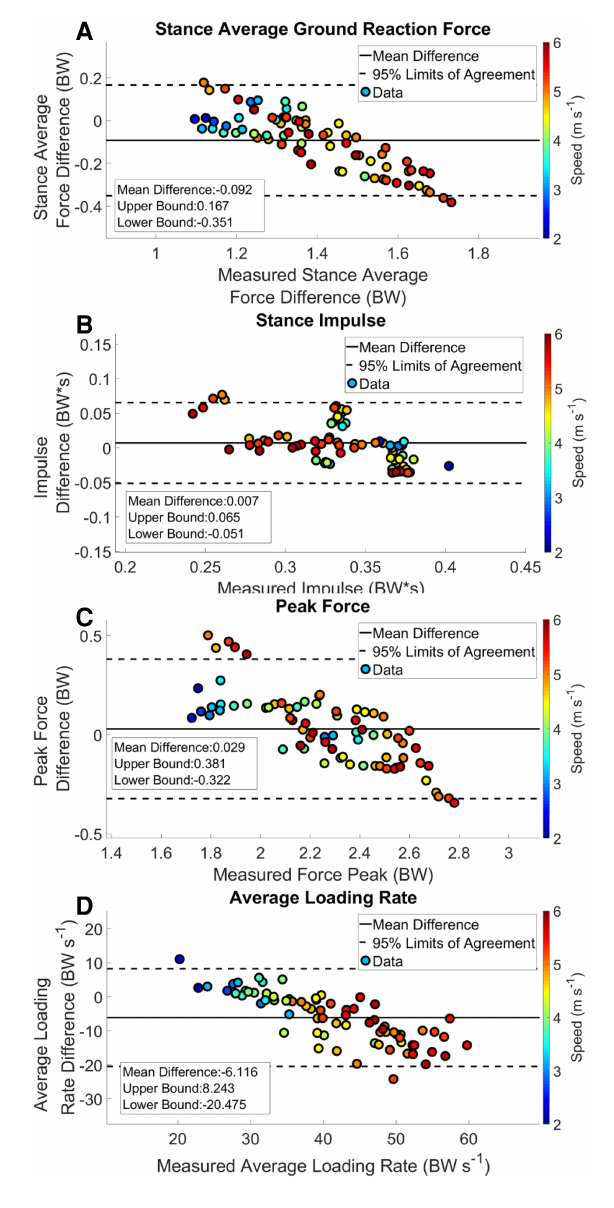
FIGURE 5 Bland Altman plot with offset and 95% limits of agreement. Each data point represents an average speed trial. The color of a trial represents the average running speed of the